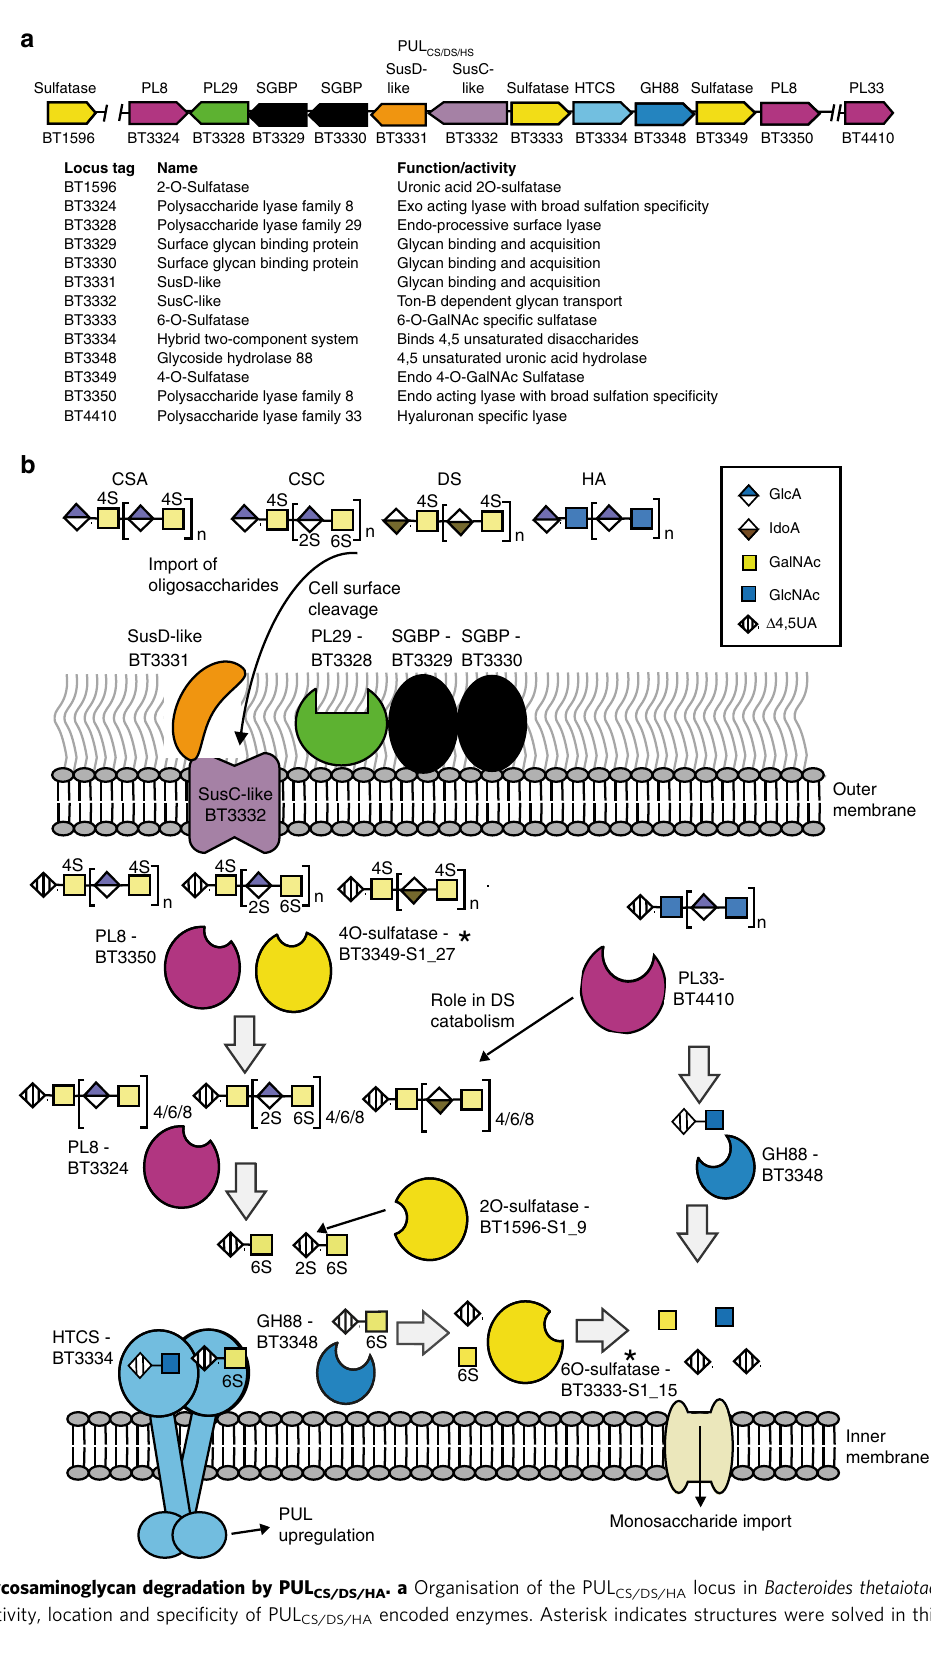
Fig. 1 Model of glycosaminoglycan degradation by PUL CS/DS/HA . a Organisation of the PUL CS/DS/HA locus in Bacteroides thetaiotaomicron . b Schematic depiction of the activity, location and speci fi city of PUL CS/DS/HA encoded enzymes. Asterisk indicates structures were solved in this